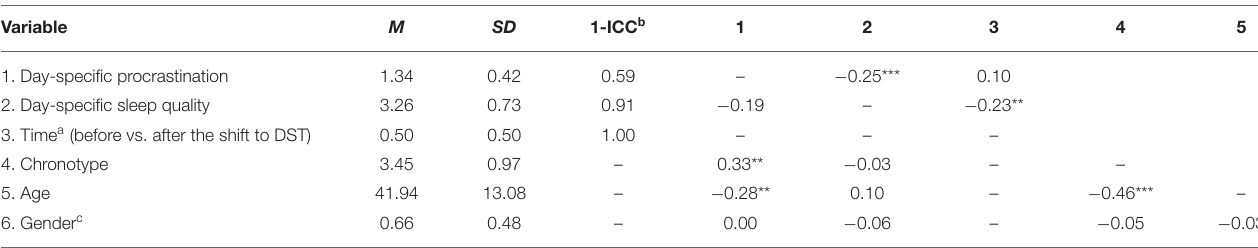
TABLE 1 | Means, standard deviations, and correlations of variables.